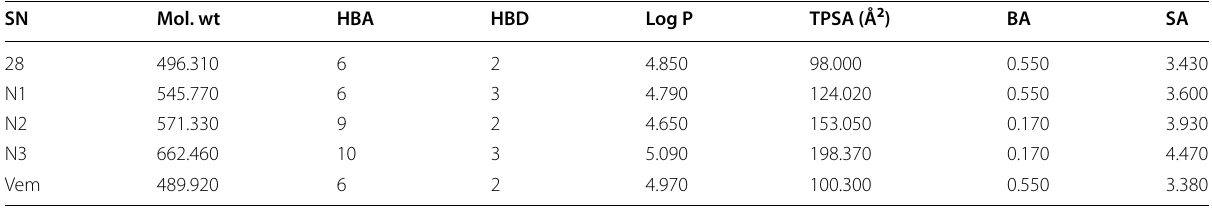
Table 3 Predicted drug-likeness based on the Lipinski’s rule including bioavailability (BA) and synthetic accessibility (SA) of compound 28, designed compounds and